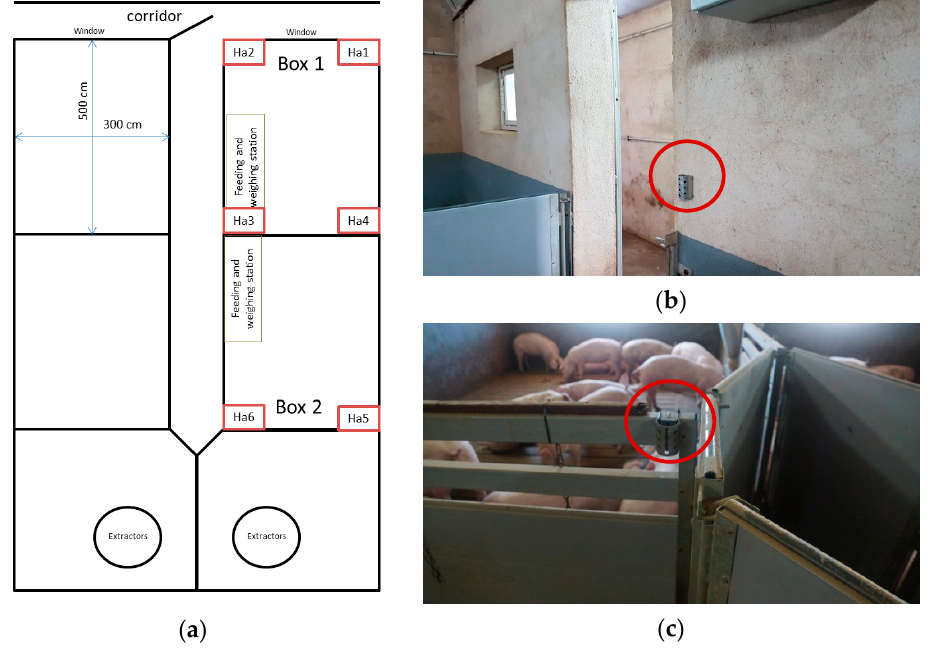
Figure 3. ( a ) Distribution plan of the six environmental sensors (from Ha1 to Ha6). ( b , c ) Detail of the installation of two loggers (Ha2 and Ha6 on the map), earmarked by a red circle are the environmental